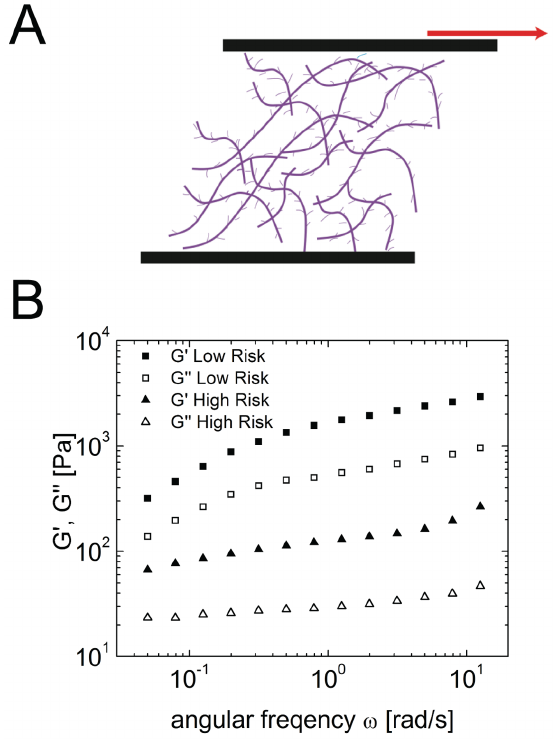
Figure 3. (A) Diagram of shear rheology. Rotational shear force applied to cervical mucus sample. (B) Example linear viscoelastic spectra of high risk and low risk cervical mucus samples. Storage modulus G 9 and loss modulus G’’ of low risk mucus is an order of magnitude greater than that of high-risk mucus, indicating that high- risk mucus is more weakly cross-linked than low-risk mucus. doi:10.1371/journal.pone.0069528.g003 (capacity to form filaments) [29]. 200 6 100 m L of cervical mucus sample was placed between two circular metal plates that were 6 mm in diameter, with an initial gap of 2 mm. The plates were then separated to a distance of 20 mm (maximum separation distance attainable with our CaBER device) at a constant rate of 3.6 mm/s and the separation distance at which the sample broke (‘‘break point’’) was recorded. For statistical calculations, a ‘‘break